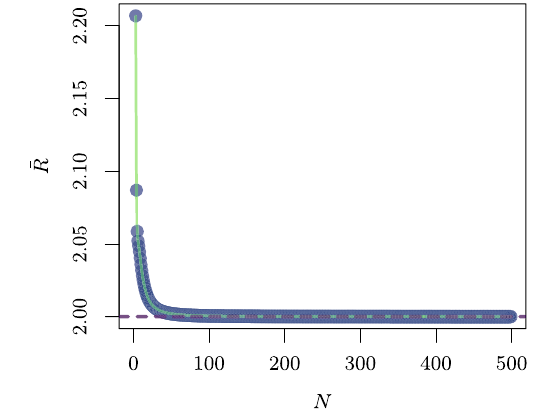
Fig. 7 The scalar curvature is followed as a function of N for the ignorable coordinate case for a = 1, with the dashed lines representing the expected value at 2